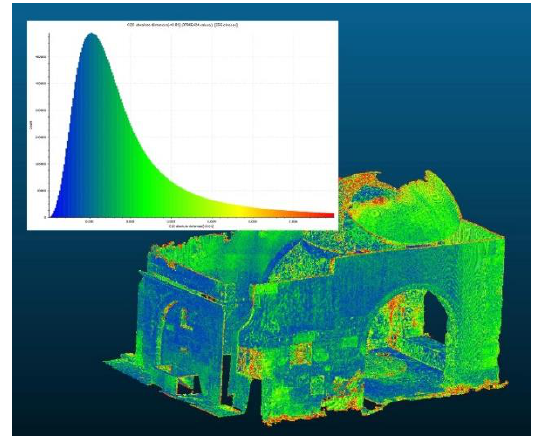
Figure 2: KaraMousa, differences between the laser scanner and the photogrammetric point-cloud. Despite the complexity of the architecture, the error is below 3mm (red) on the rooftop and around the building, which was hardly accessible and mostly covered from a closeby three or grass, and mostly between 1 and 2mm (blue and green).